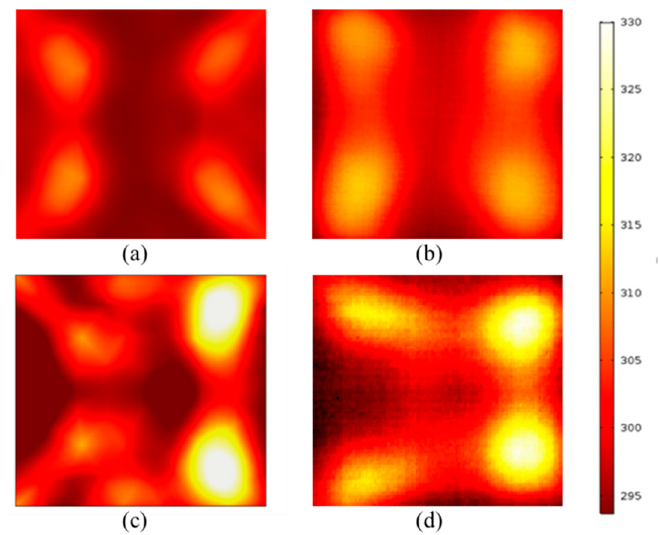
Figure 6. Experiment and simulation results of potato surface temperature distribution (unit: K): ( a ) Simulated heating results of the fixed frequency heating; ( b ) experimental heating results of the fixed frequency heating; ( c ) simulated heating results of the sweep frequency heating; and ( d ) experimental heating results of the sweep frequency heating.